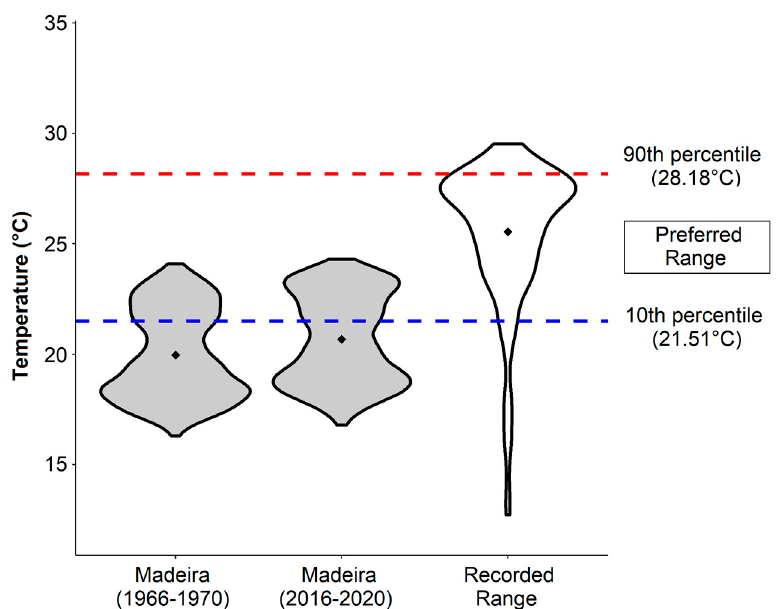
Figure 3. The sea surface temperatures range in Madeira in the past and present (daily SST from 1966–1970 and 2016–2020, data source: [66]) compared to the recorded and preferred temperature range for Chilomycterus reticulatus (based on Aquamaps, [27]). Means are indicated as points.